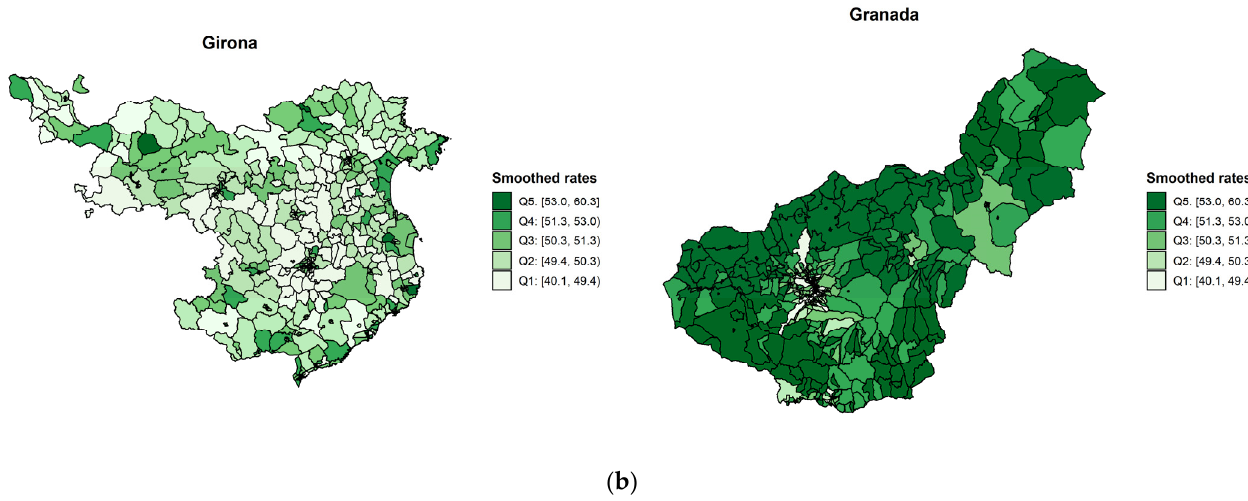
Figure 3. ( a ) Lung observed incidence rates and ( b ) smoothed cancer incidence rates adjusted for deprivation and age by census tract in two Spanish provinces during the period 2011–2012.